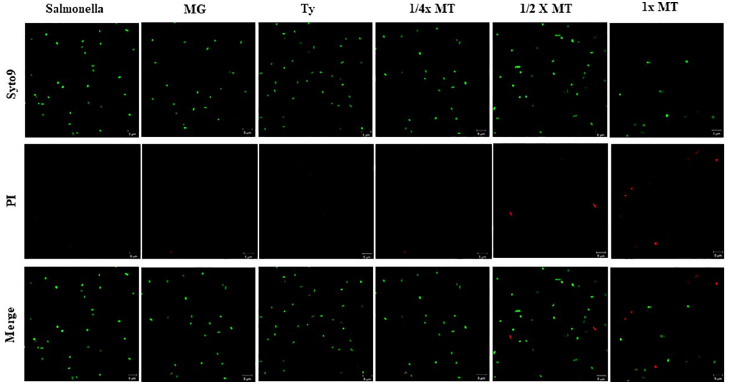
Fig 2. Confocal laser scanning microscopy analysis of the membrane integrity of S . Typhimurium (ATCC 14028) treated with methyl gallate (MG), tylosin (Ty) and various concentrations of their combination (MT). SYTO9/PI staining was applied to differentiate cells with intact membranes (green) from those with damaged membranes (red). Salmonella : non-treated S . Typhimurium. MG = 128 μ g/mL; Ty = 256 μ g/mL; ¼× MT = 32 μ g/mL MG and 64 μ g/mL Ty; ½× MT = 64 μ g/mL MG and 128 μ g/mL Ty; and 1 × MT = 128 μ g/mL MG and 256 μ g/mL Ty.